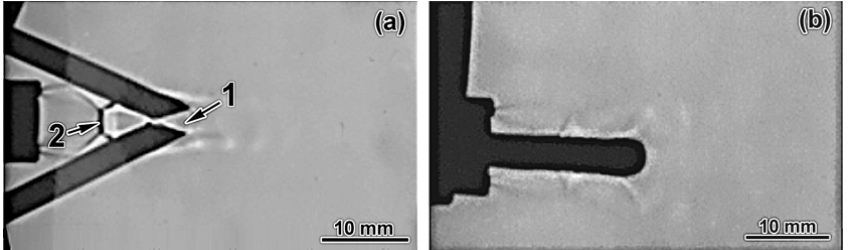
Figure 4. Gas spectrograms of the airflow passing the crossed electrodes: ( a ) the “top view”, ( b ) the “side view” (1—depression area, 2—Mach disc).